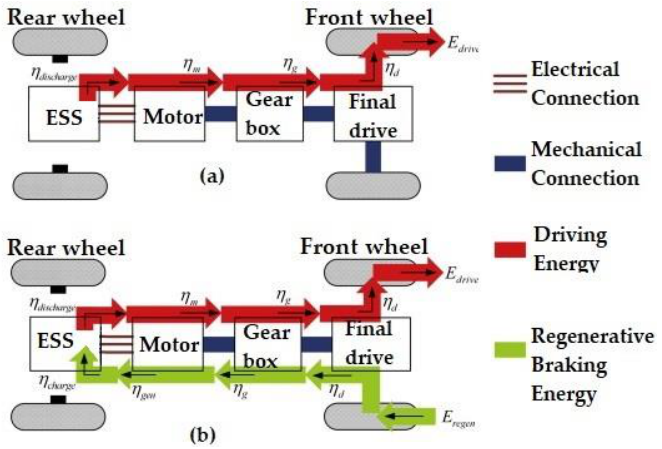
Figure 11. The Energy flow with and without RBS [151].